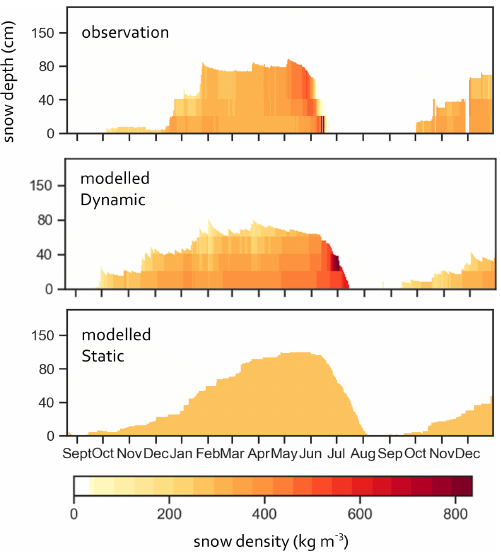
Figure 3. Snowpack dynamics at the Zackenberg GeoBasis station. Density values for the layers are extrapolated – from three and five layers for the observational and modelled data, respectively. The colours of the snowpack indicate snow